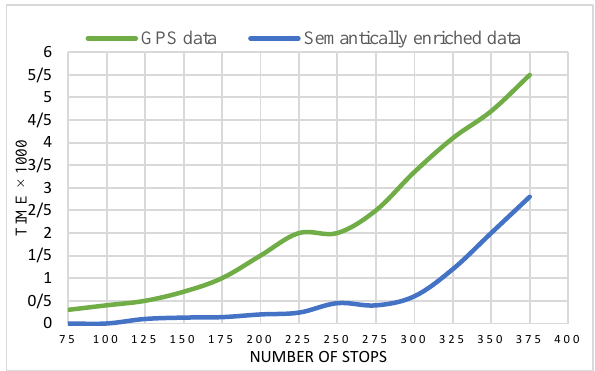
Figure 13. Reasoning computation time using GPS data and semantically enriched data.